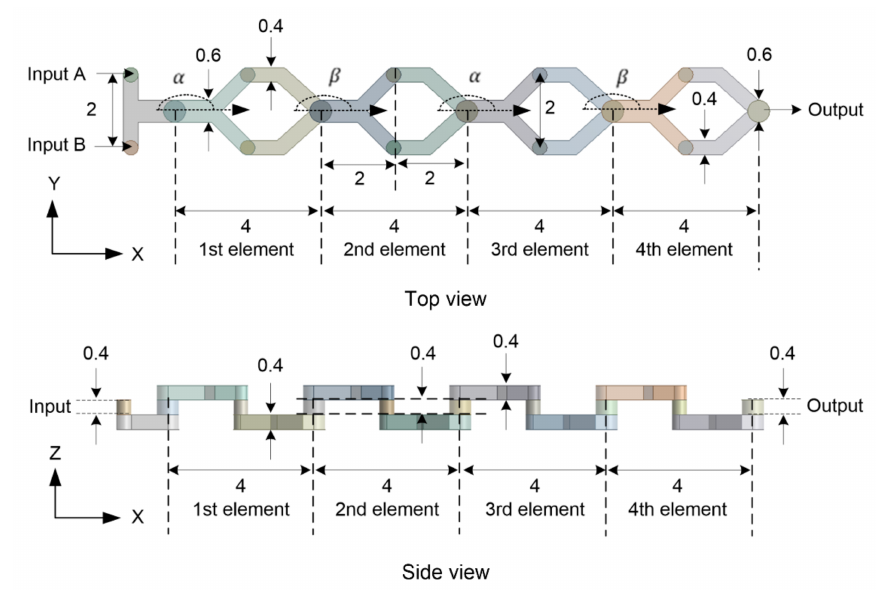
Figure 1. Diagram of the proposed ( Y − U ) micromixer (all the dimensions are in mm). β The angle of each element with the X-axis is represented by α and β as shown in Figure 1. The angle α is always kept constant with a value of 0 ◦ whereas angle β is changed from 0 ◦ to 90 ◦ ; increased 15 ◦ in each time. Therefore, there are seven ‘ ( Y − U ) ’ β ( β = 0 ◦ ) , mixers in total with different values of angle β that are represented by ( Y − U ) 0 ◦ ( Y − U ) ( β = 15 ◦ ) , ( Y − U ) ( β = 30 ◦ ) , ( Y − U ) ( β = 45 ◦ ) , ( Y − U ) ( β = 60 ◦ ) , 15 ◦ 30 ◦ 45 ◦ 60 ◦ ( Y − U ) ( β = 75 ◦ ) and ( Y − U ) ( β = 90 ◦ ) . Figure 2 illustrated the ( Y − U ) mixer 75 ◦ 90 ◦ 45 ◦ with α = 0 ◦ and β = 45 ◦ as an example.